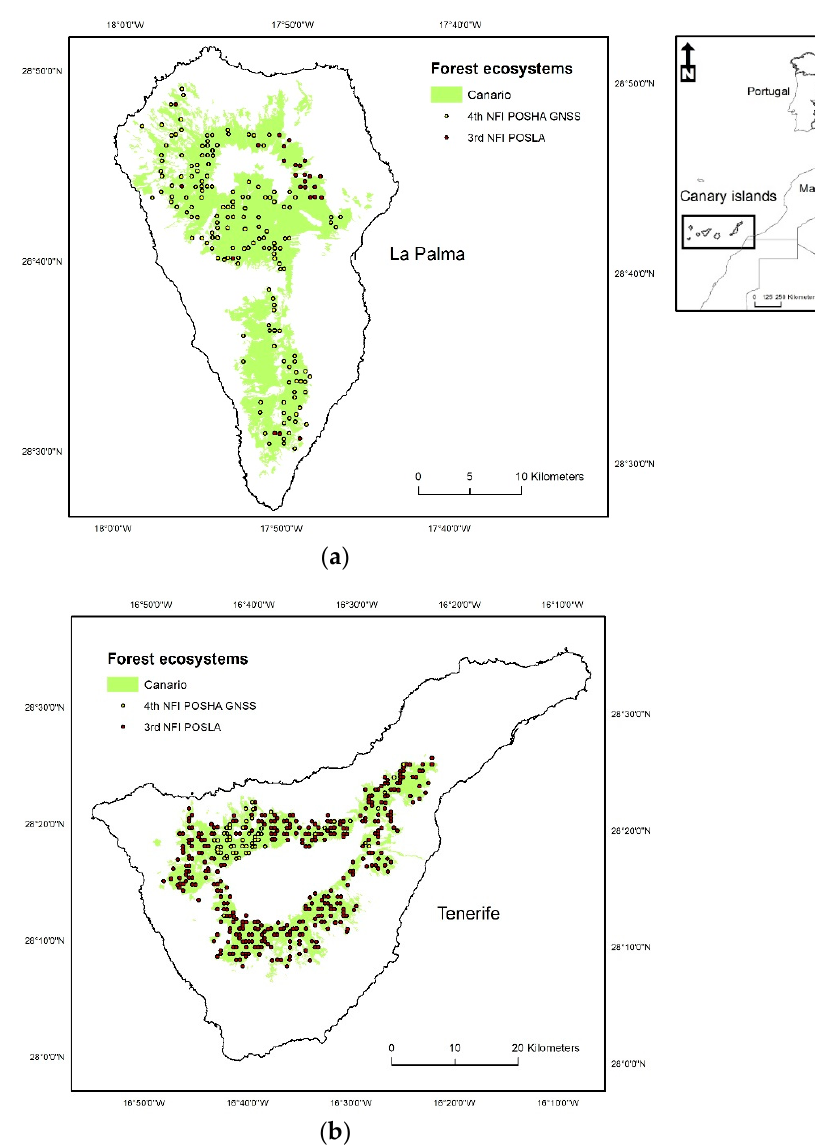
Figure 2. ( a ) Spatial arrangement of NFI samples for Canario (Pinus canariensis) on La Palma Island. The NFI samples whose coordinates were registered in the 4th round using Global Navigation Satellite Systems ( POS HA ) and in the 3rd round using traditional positioning ( POS LA ) are displayed. ( b ) Same for Tenerife Island, the largest island in the archipelago.